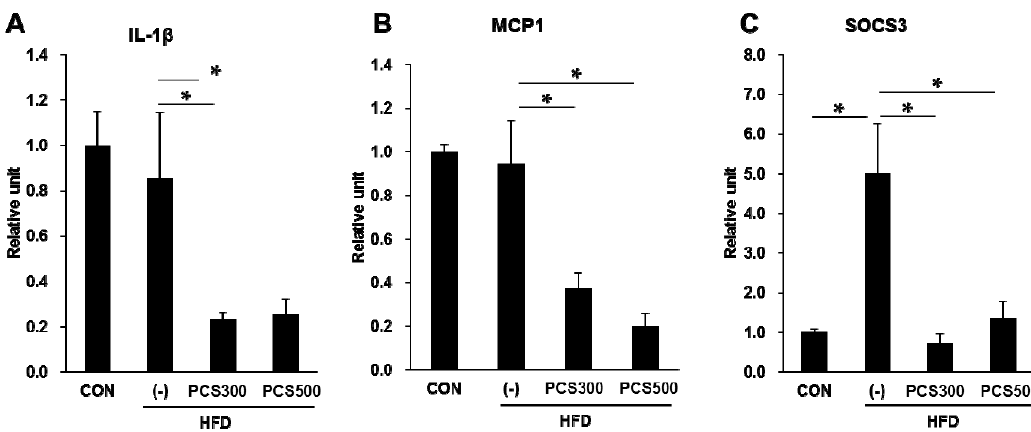
Figure 6. Effect of PCS extract on mRNA and protein expression of hepatic inflammation. Mice were fed with regular chow diet (CON) or HFD for 12 weeks. HFD-fed were treated with vehicle ( − ) or PCS extract (300 or 500 mg/kg/day) from the first day of HFD feeding ( n = 7–10/group). After 12 weeks of PCS extract treatment, total RNA was extracted from the liver tissue qRT-PCR analysis was performed for ( A ) interleukin-1 β (IL-1 β ) ; ( B ) monocyte chemoattractant protein 1 (MCP1) ; and ( C ) suppressor of cytokine signaling 3 (SOCS3) . * p < 0.05 vs. vehicle-treated HFD-fed mice.